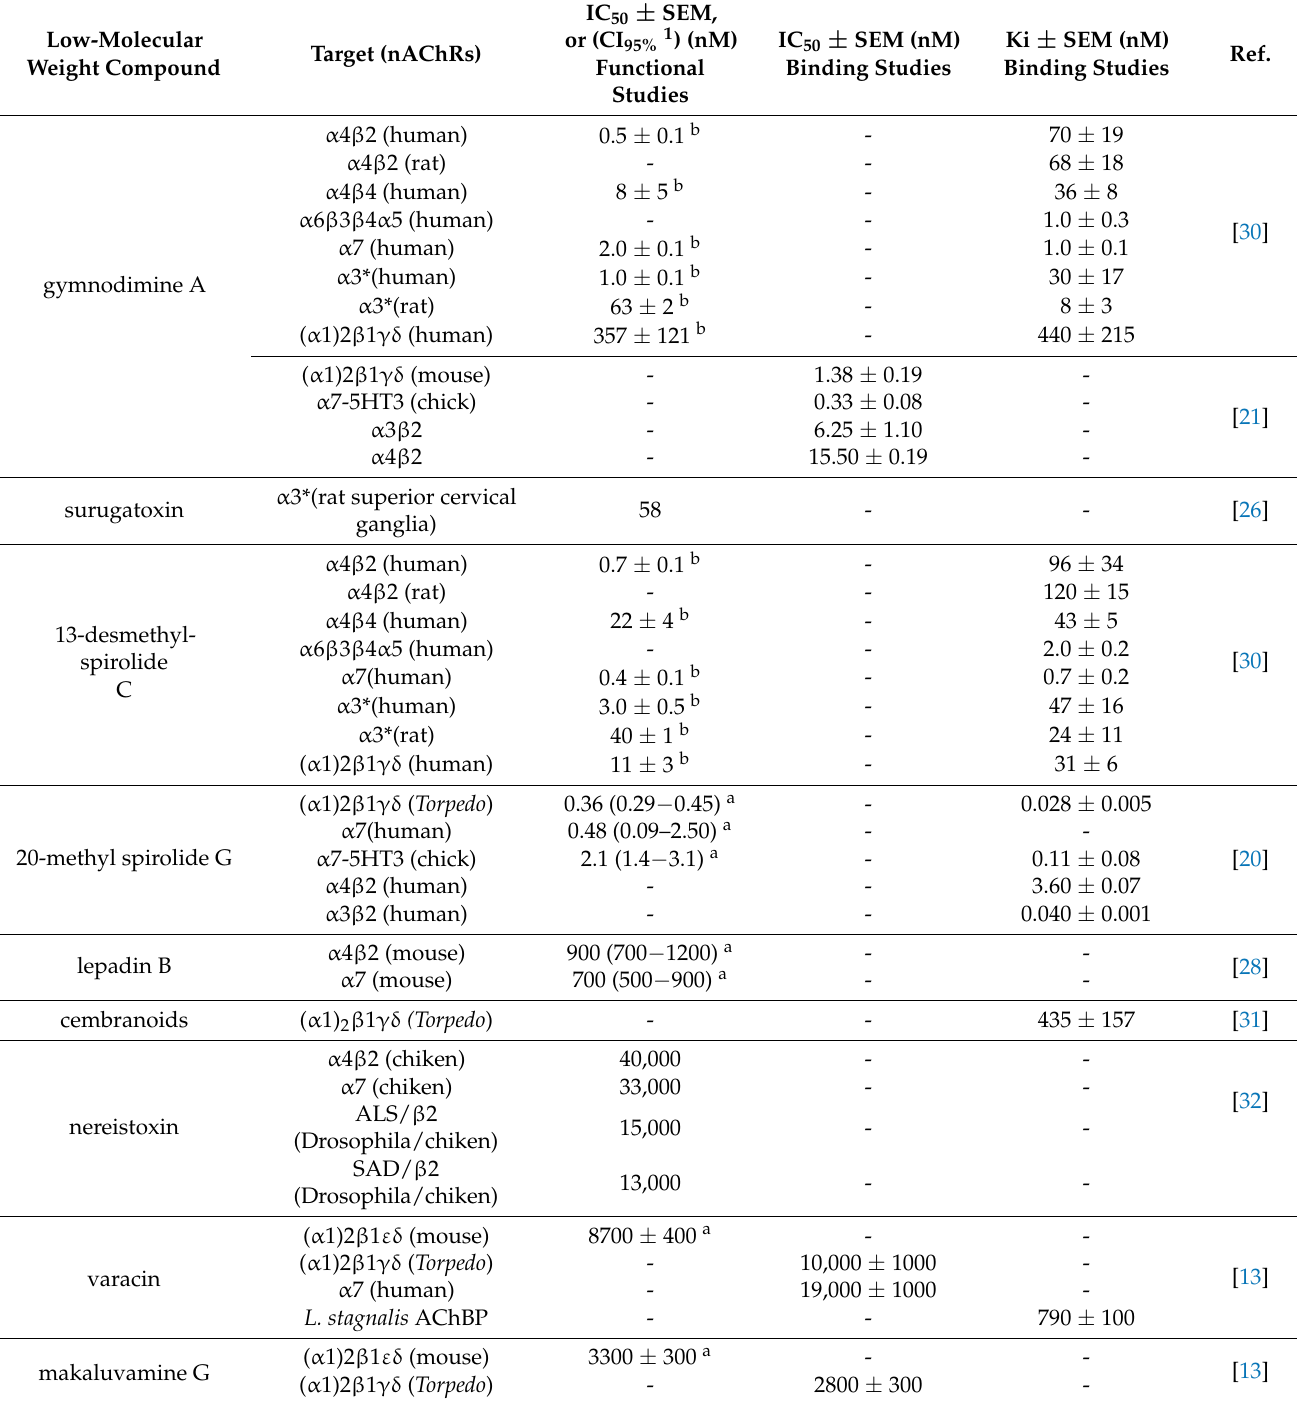
Table 1. Affinity and potency data on marine low molecular weight nicotinic acetylcholine receptor (nAChR)